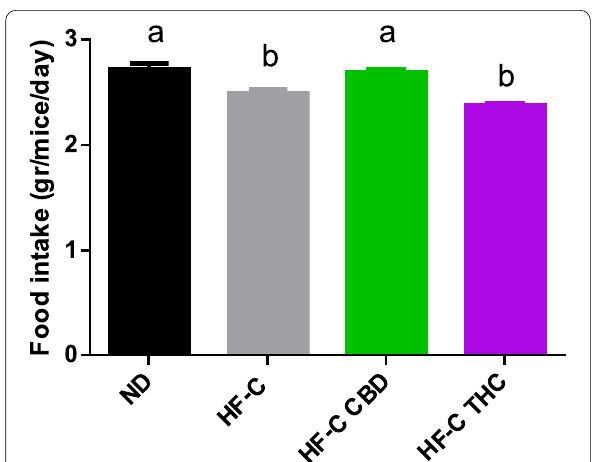
Fig. 2 Effect of THC or CBD treatment on food intake in mice fed HFCD. Male C57BL/6J mice aged 7–8 weeks were fed either normal diet (ND, n 8), high fat 1%(w/w) cholesterol 0.5%(w/w) cholate = + + diet (HF‑C, n 8), HFCD containing CBD (2.39 mg/kg) (HF‑C CBD, n = = 8), HFCD containing THC (2.5 mg/kg) (HF‑C THC, n 8). Average food = intake per mouse per day over the experiment duration is expressed as mean SEM. Columns marked with different letters (a, b) are ± significantly different ( p < 0.05) according to the Tukey–Kramer post hoc